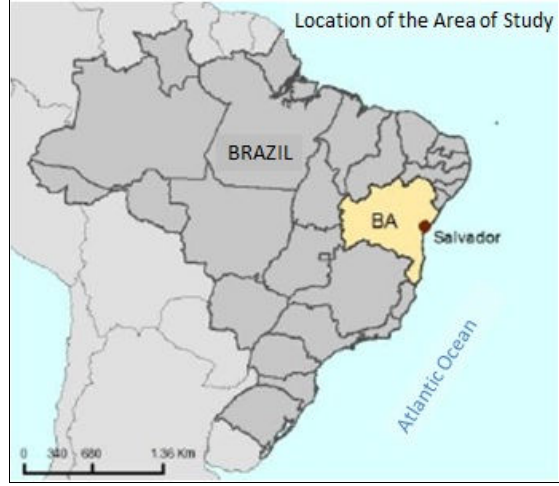
Figure 1. Map of the location of Salvador Official data from the Public Security Bureau of Bahia (SSP) of the year 2012 (2013 data were not yet available) and collaborative data from the website “Onde Fui Roubado”, both for the second half of the year (July-December) was